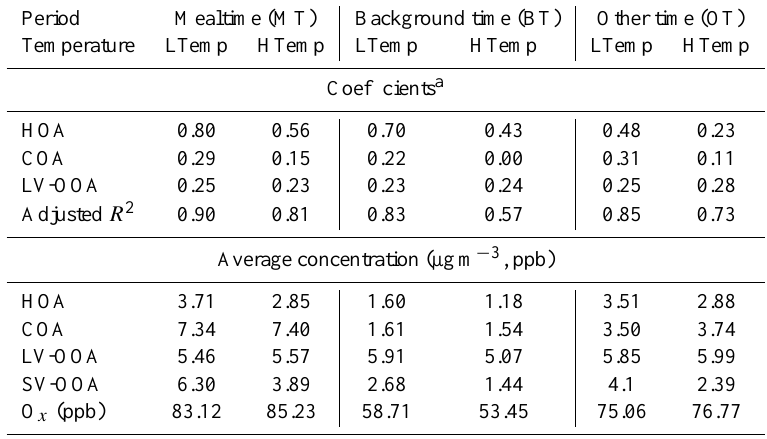
Table 2. Regression of SV-OOA on HOA, COA and LV-OOA and concentrations of OA factors and O x under high and low temperature (LT and HT) of the three chosen periods (MT, BT and OT). Period Mealtime